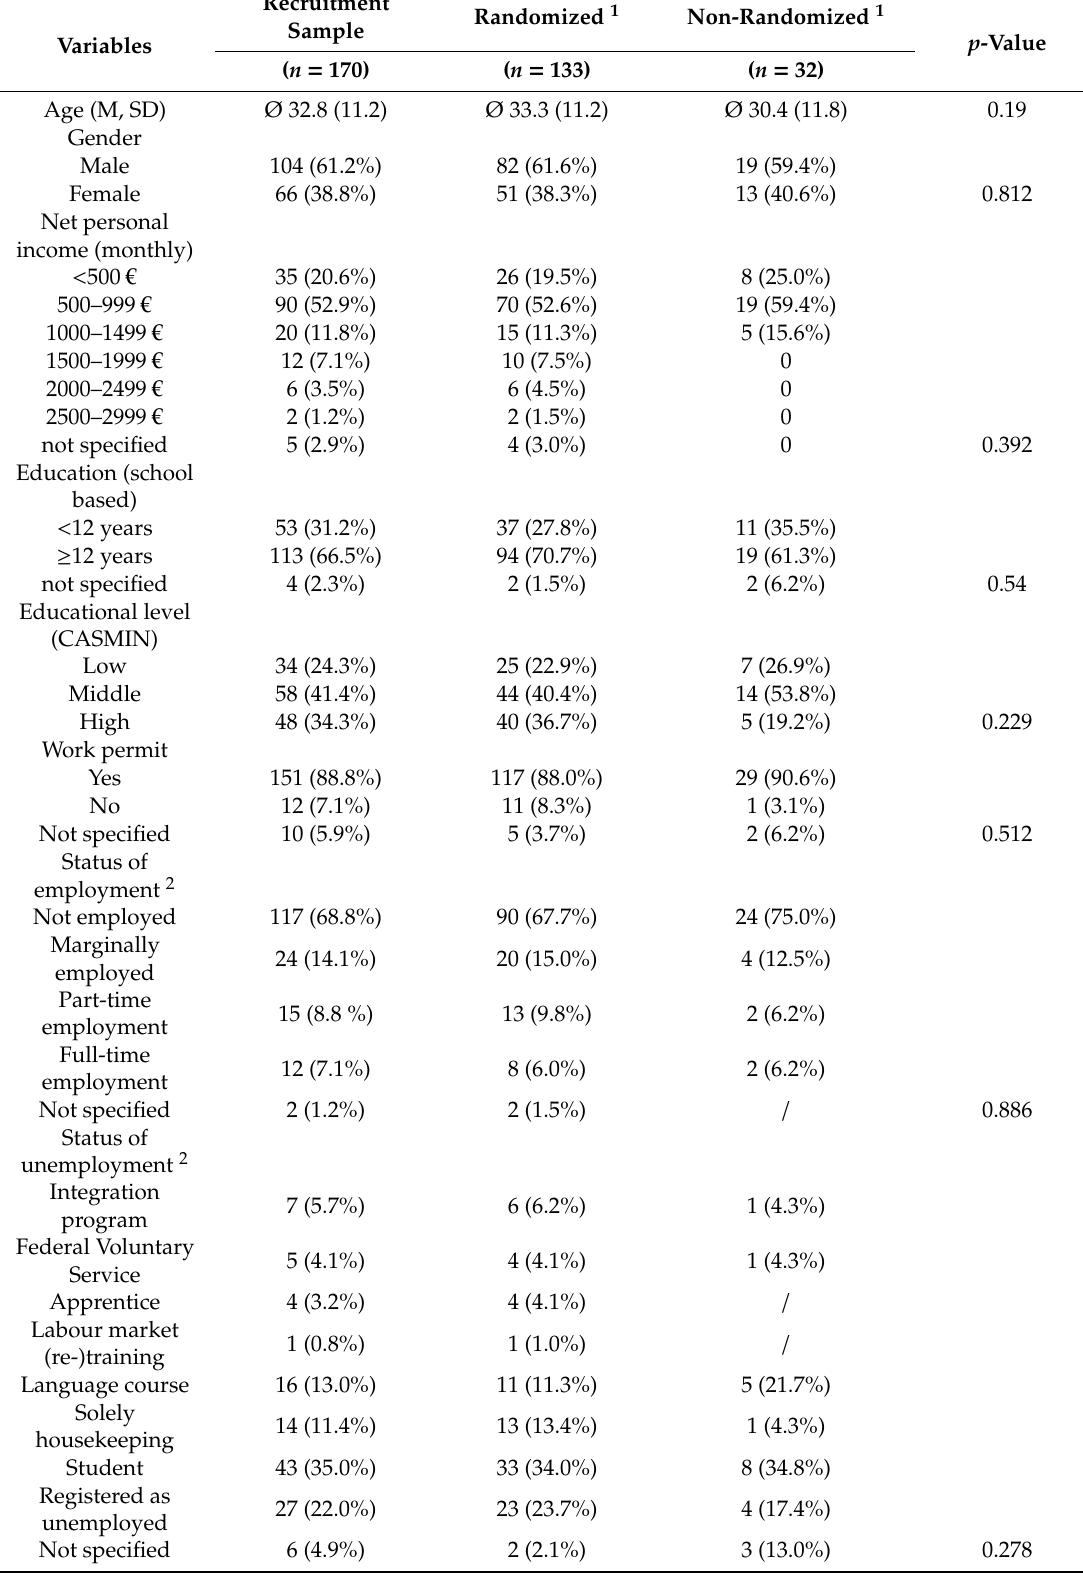
Table 1. Sociodemographic characteristics of the recruitment sample screened for eligibility in the “Sanadak” trial with regard to randomization